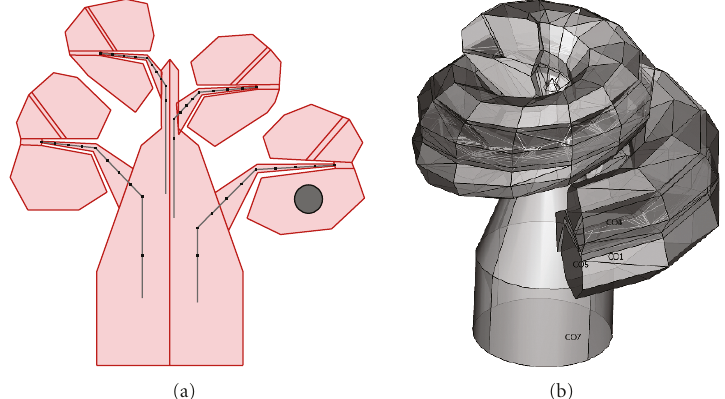
Figure 3: Visualization of 3D cochlear model. (a): Cross-section view of the model. Nerve fibers are shown as gray lines, with black dots at the boundaries between sections. One electrode positioned in the Scala Tympani is shown as a circle. (b): External view of the model